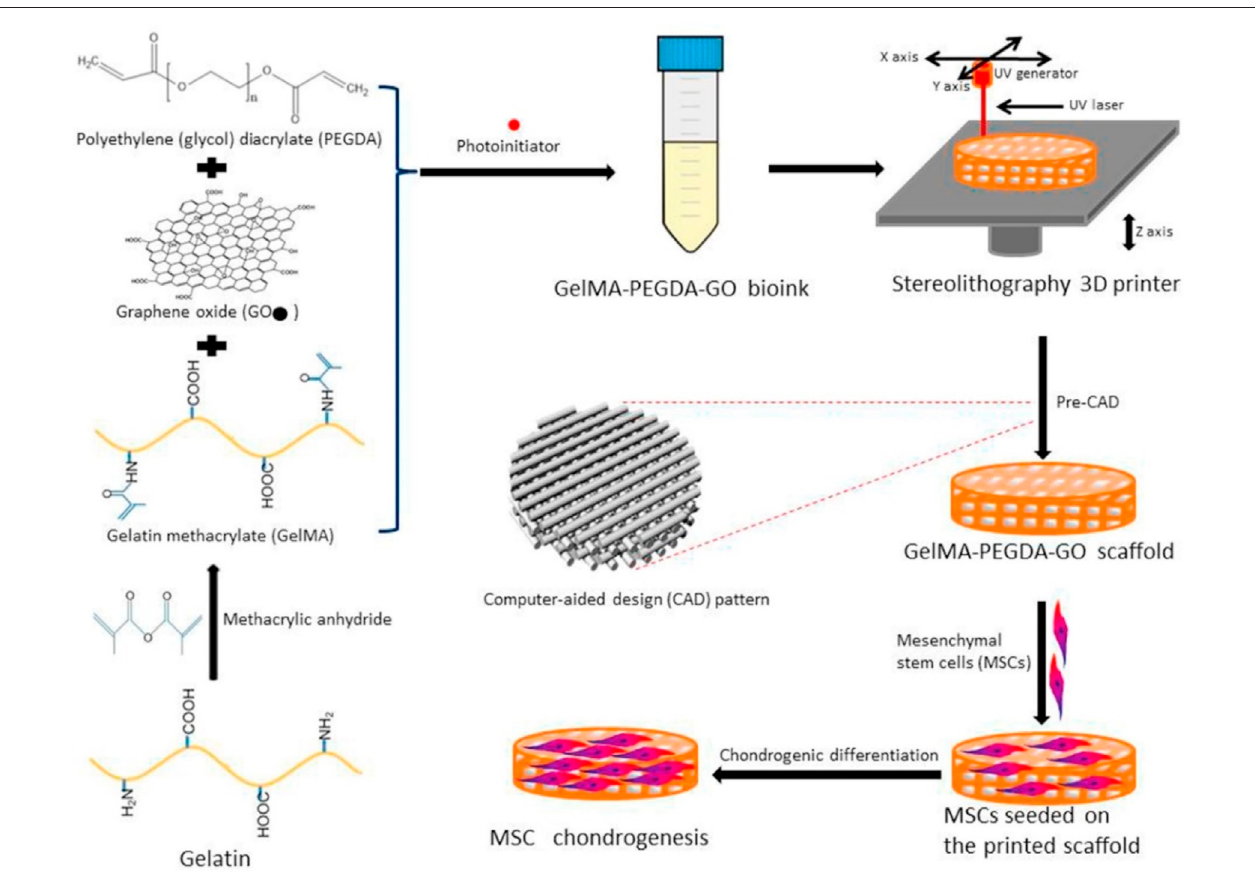
FIGURE 8 | Schematic preparation of bioprinting scaffold to promote chondrogenic differentiation. Reproduced from Zhou et al., (2017) with permission from Copyright 2017 Royal Society of Chemistry.